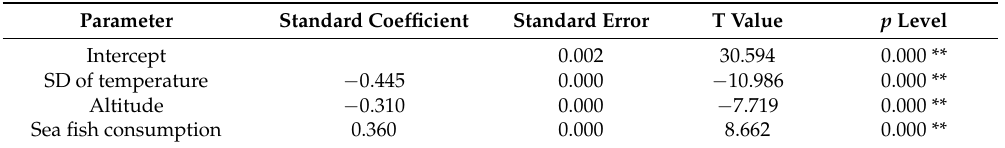
Table 4. Regression coefficient, standard error, t-value and probability of the estimated parameters in longevity model by the stepwise multiple linear regression (MLR) analysis in 2000.